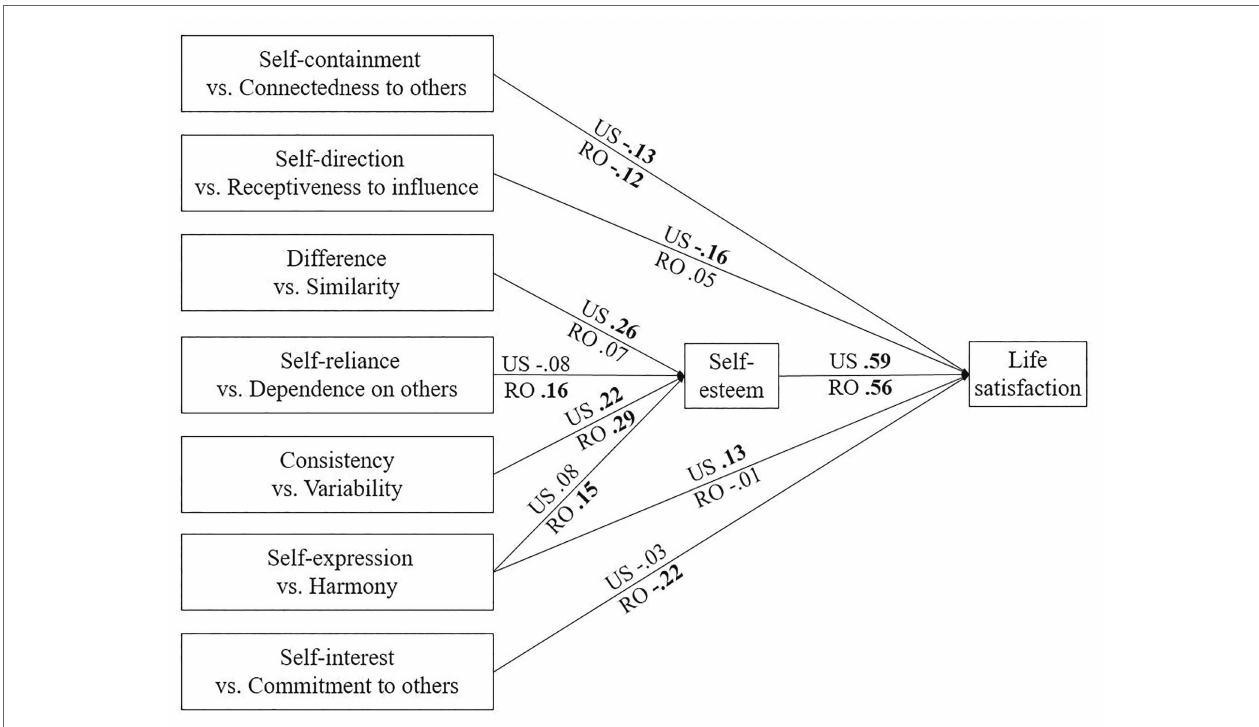
FIGURE 2 | Path model of the relationships between self-construal dimensions, self-esteem, and life satisfaction. In this figure, the values shown are standardized path coefficients. The paths that were not statistically significant in at least one sample are not showed; the statistically significant coefficients are shown in bold; US, United States sample; RO, Romanian